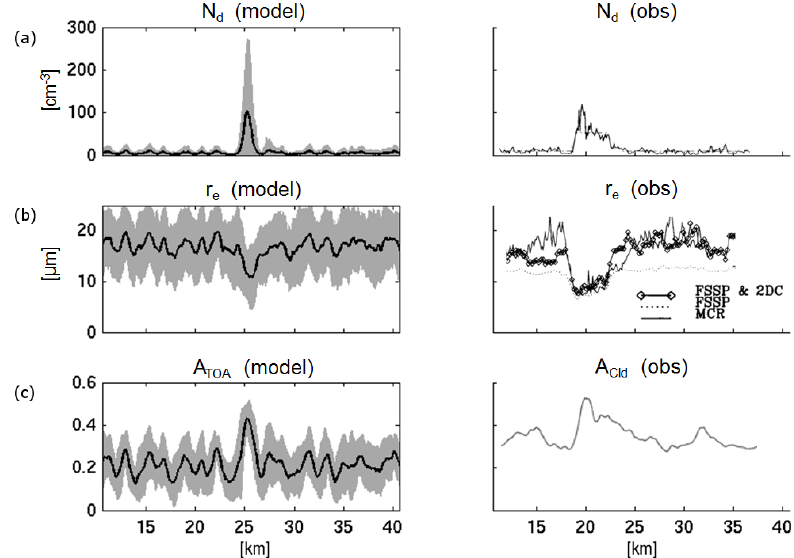
Figure 11. Model transects at hour 8.7 of (a) N d , (b) r e , and (c) albedo. We compare the modeled top of atmosphere albedo ( A TOA ) with the observed cloud albedo ( A Cld , as the 3d fields for radiative fluxes were not saved and thus computing a modeled cloud albedo is not possible. In each panel, the heavy black curve is the domain y -average, and the grey-filled region is bounded by ± 2 σ about the mean, where σ is calculated at each x as the square root of the variance of all values in y . Observations from Taylor and Ackerman (1999) Figs. 2, 4, and 5 are reproduced in the right hand column. The model transects are shown for the time that most nearly corresponds with the observed transects in terms of downstream evolution after aerosol perturbation (about